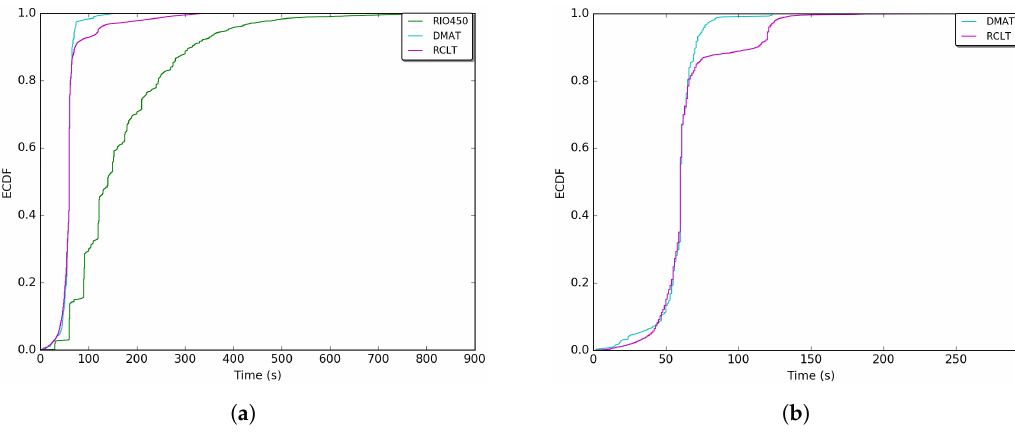
Figure 9. ECDF of the real GPS times of unavailability retrieved from the datasets. ( a ) GPS times of unavailability on the entrance exit sense; ( b ) GPS times of unavailability on the exit entrance